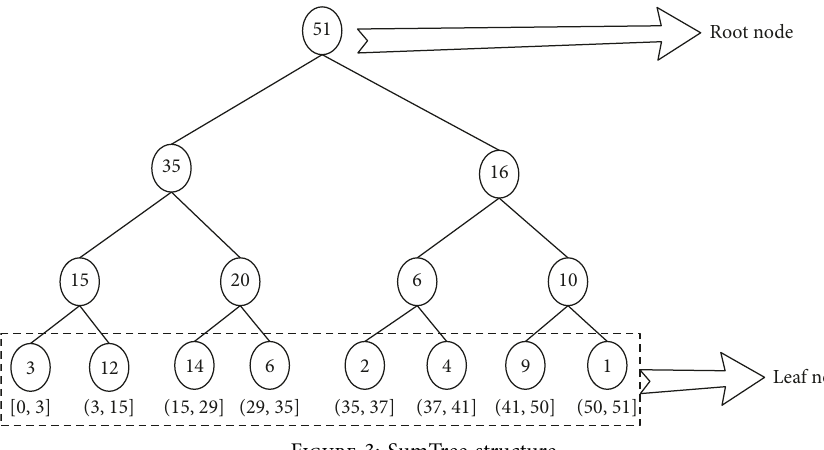
Figure 3: SumTree